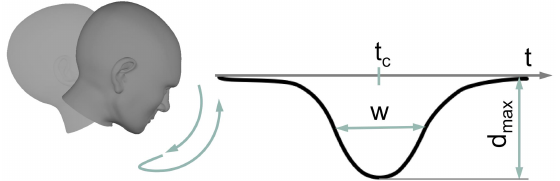
Figure 6. Head Gesture. The gesture is displayed with its ϑ h r -angles over time t . Parameters: d max = amplitude, w = peak width, t c = location of the peak